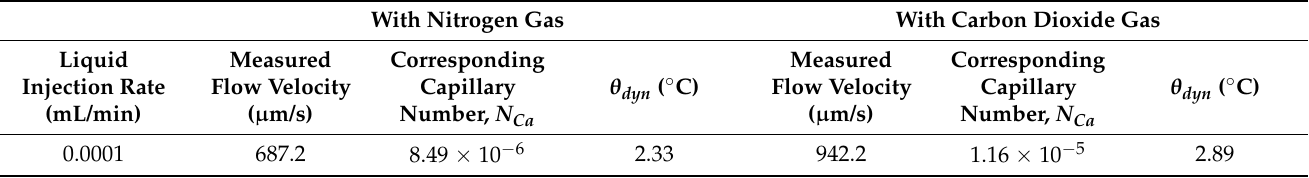
Table 3. Liquid Injection